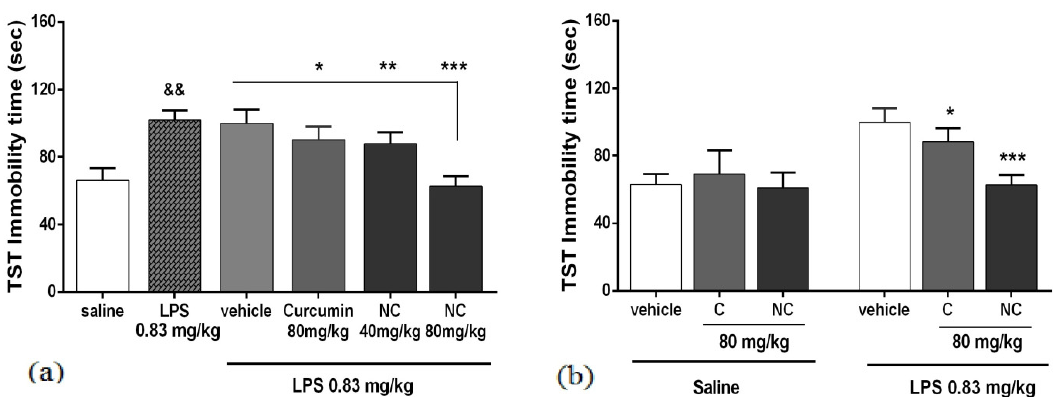
Fig. 2. Effect of curcumin (C) 80 mg/kg, i.p. and nanocurcumin (NC) 40 and 80 mg/kg, i.p. on duration of immobility (sec.) in tail suspension test (TST) on saline- and lipopolysaccharide (LPS)-treated mice. && P<0.01 significantly different from saline